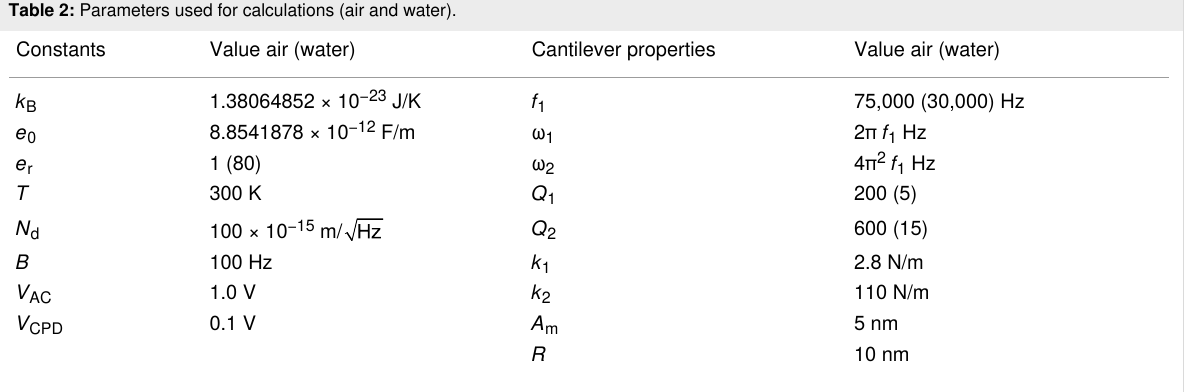
Table 2: Parameters used for calculations (air and